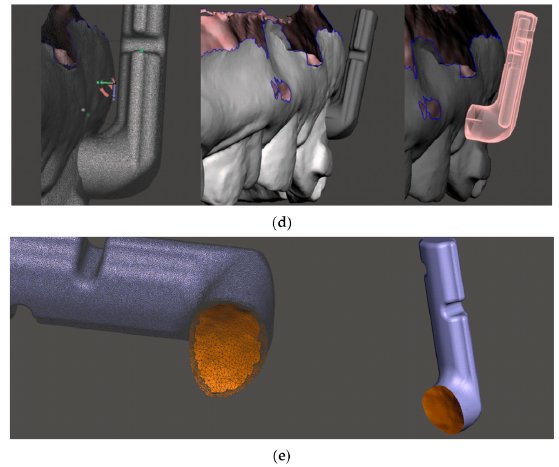
Figure 7. ( a ) Method of creating individual base of a power-arm—first step, identification of clinical surfaces of teeth for PA, not covered with clear aligner system (Invisalign ® ). ( b ) Virtual setup in clinically driven positioning of the power-arm (variant II). ( c ) Aligning PA to a tooth axis on digital intraoral scan (iTero ® Intraoral Scanner). ( d ) PA must respect 1mm distance from the gum to avoid swelling from mechanical irritation, as well as it must respect individual vestibular anatomy of a patient. ( e ) When the part of PA STL template that overlaps the tooth is removed, it forms an individual base on the PA. Individual base is effective in proper PA positioning during bonding, as well as significantly increases PA retention on the tooth [15].